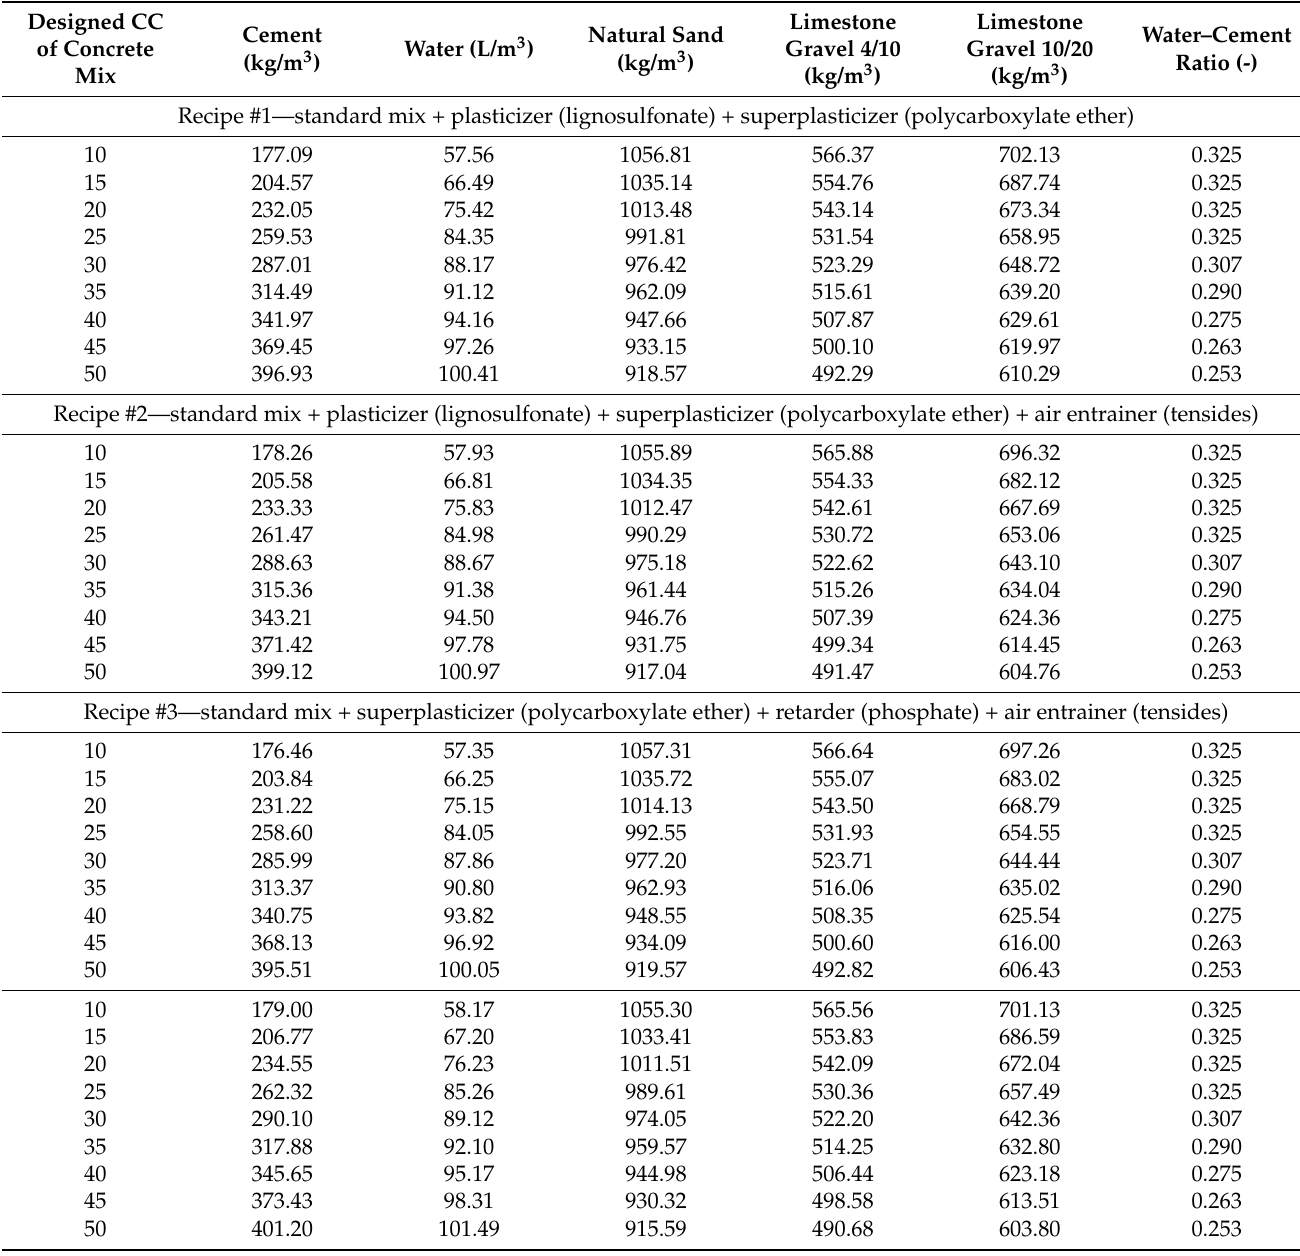
Table 4. Tested concrete mix recipes designed according to Fuller